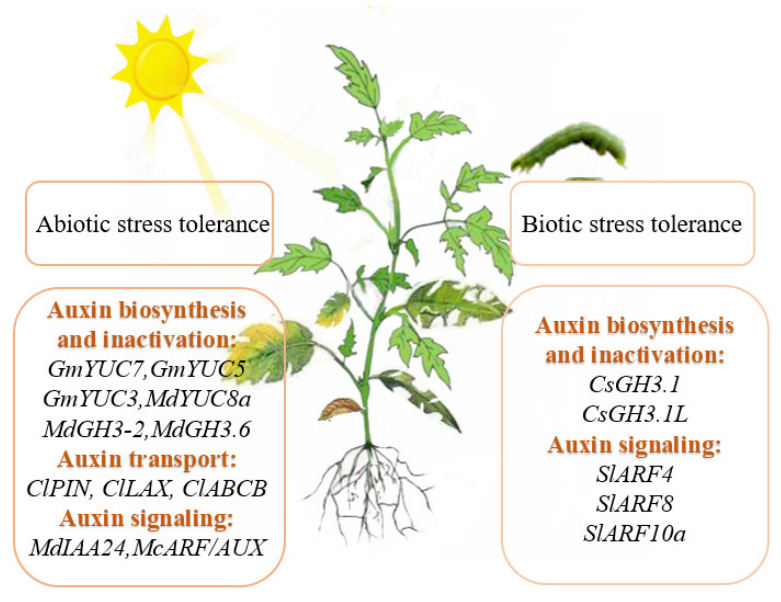
Figure 4. Auxin-related genes that play a role in stress tolerance of horticultural plants.